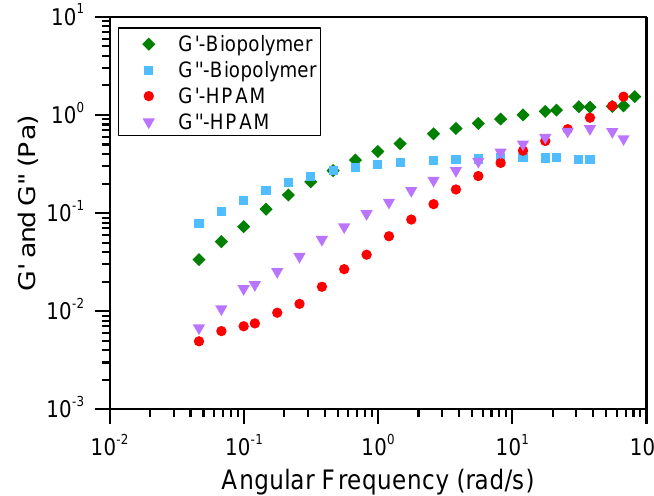
Figure 5. Viscous (G ″ ) and elastic (G ′ ) moduli of HPAM and biopolymer.